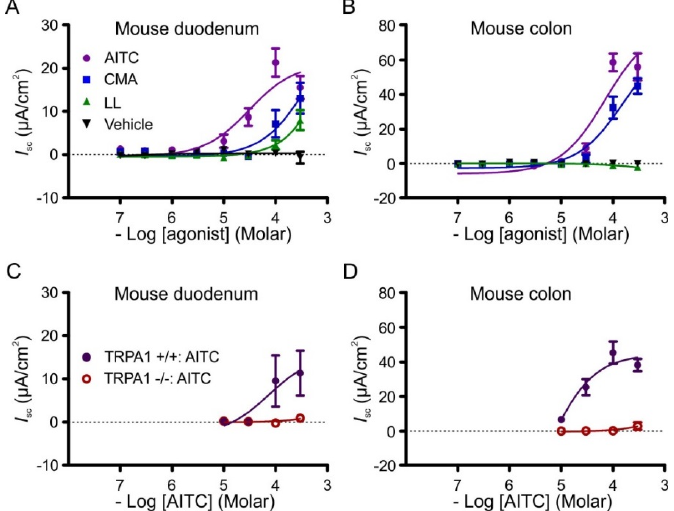
Figure 3. Concentration ‐ response relationships for TRPA1 agonists on Trpa1 +/+ and − / − tissues in Ussing chambers. Change in short circuit current ( I sc ) in response to allyl isothiocyanate (AITC), cinnamaldehyde (CMA) and linalool (LL) in wild ‐ type mouse duodenum ( A ) and distal colon ( B ); Change in I sc in response to AITC in duodenum ( C ) and distal colon ( D ) from Trpa1 − / − mice and Trpa1 +/+ mice from the same colony.